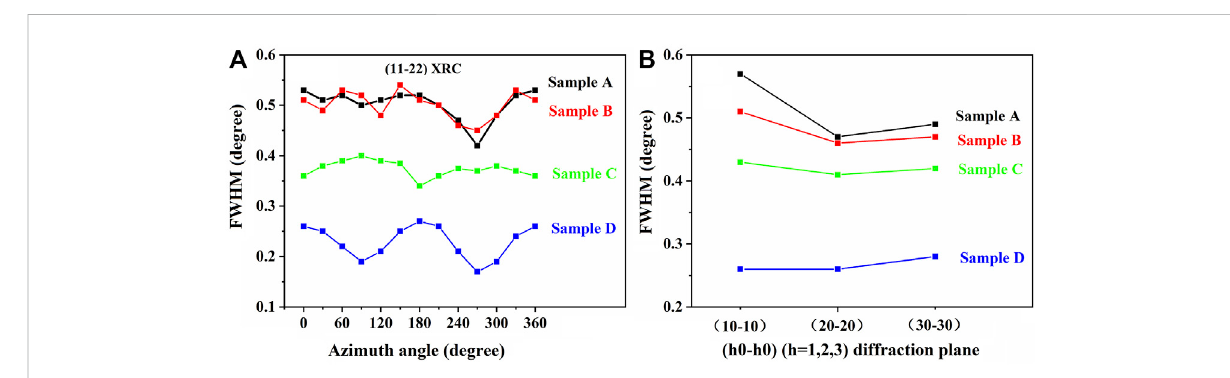
FIGURE 3 (A) FWHM of AlN [1 – 12] rocking curves as a function of azimuth angle, and (B) the FWHM of AlN [13], [10] and (30-30) rocking